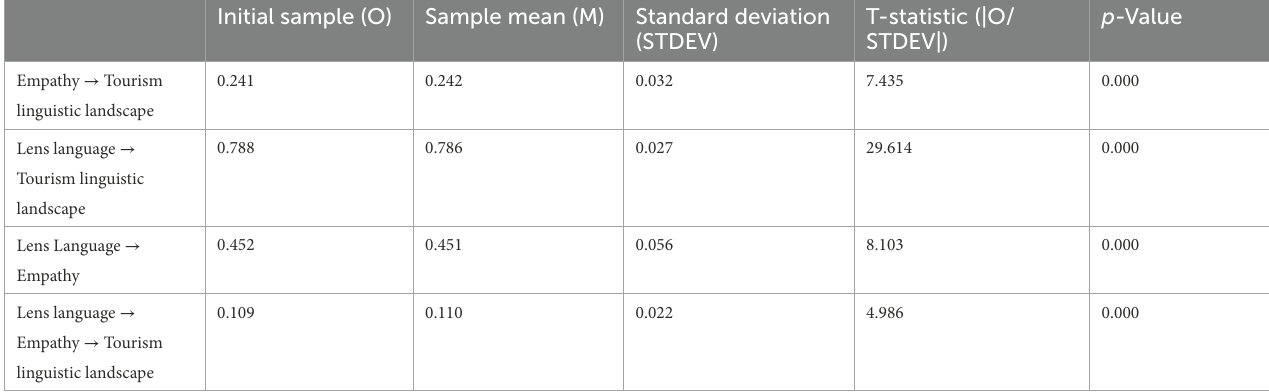
TABLE 3 Significance test results of path